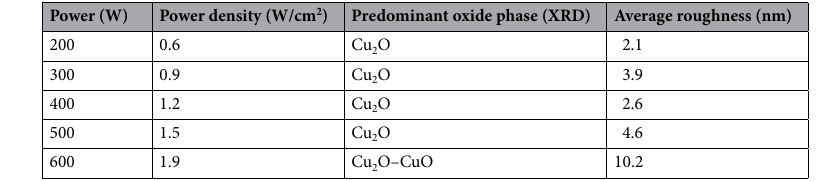
Table 2. Average roughness of films at different deposition power ranges obtained using Atomic Force Microscopy (AFM).